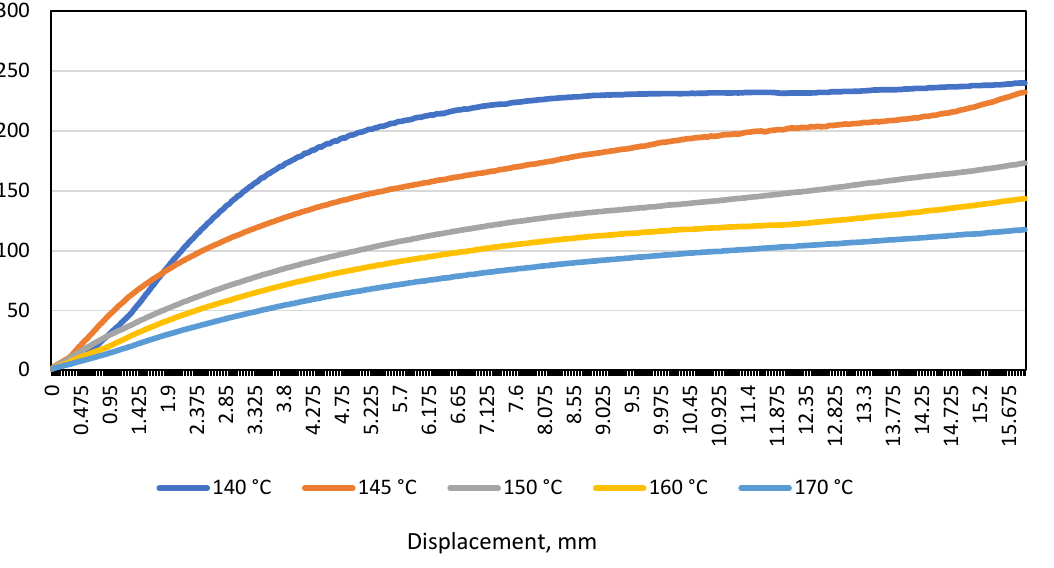
Figure 3. Load and displacement diagram of monochrome material A under bending at different temperatures when the distance between the supports was 80 mm.